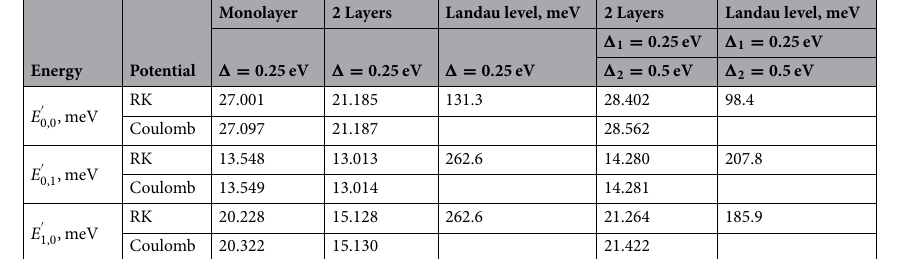
Figure 2. Left panel: the dependence of energies E ′ n , graphene layers. Calculations performed for the value of magnetic length l that corresponds to B / e Right panel: the dependence of the energies of indirect PMEs E ′ graphene layers and PMF B / e .